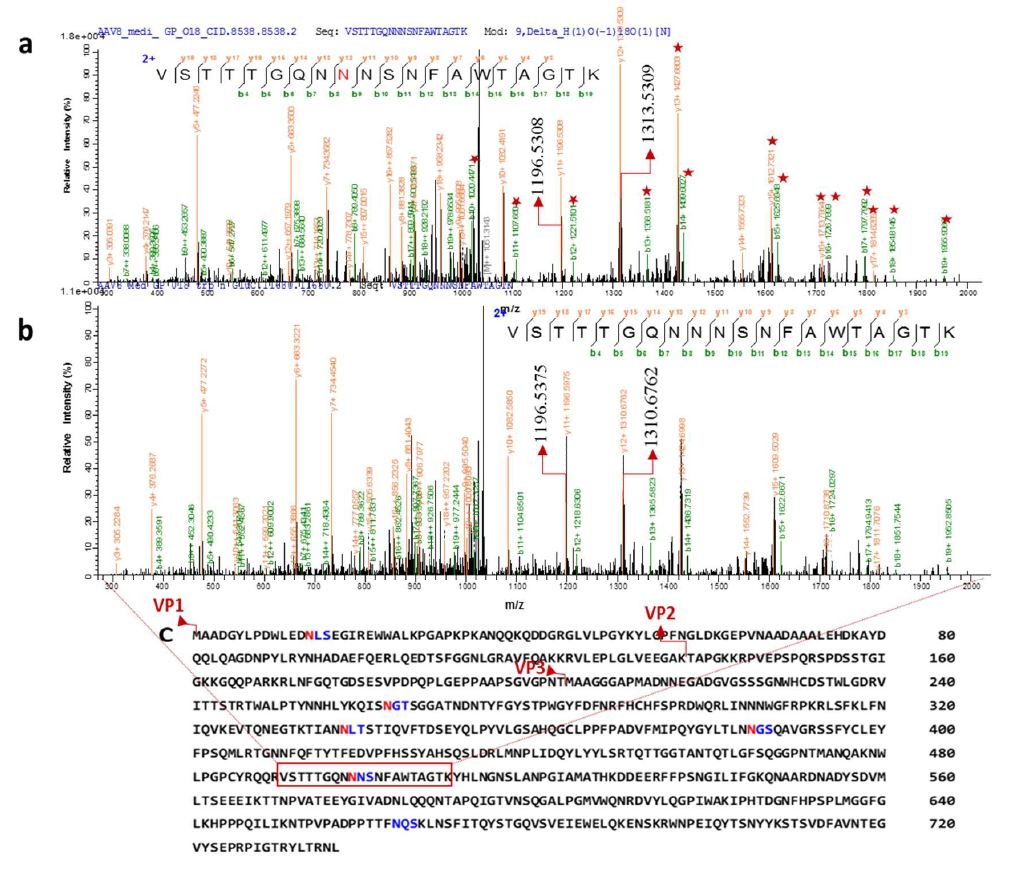
Figure 4. Two distinct tandem mass spectra of peptide sequence “VSTTTGQNNNSNFAWTAGTK” of the AAV8 capsid protein (in the common region of VPs). Characterized CID spectra of glycosylated peptide after 18 O mediated digestion. ( a ) The position of de-N-glycosylated asparagine 499 ( 18 O-incorporated aspartic acid) was attested by mass increment of 2.8547 Da (theoretical mass difference 2.98 Da) to the series of b and y ion (the precursor ion mass: m/z 2101.93193). ( b ) The position of Non-glycosylated asparagine 499 in the sequence was confirmed by y12/b8 ions (the precursor ion mass: m / z 2099.0766 Da). The highlighted ions (marked with a star) shows the mass differences from the non-glycosylated peptide mass spectrum. y11+ (highlighted) ions are same in both the spectra. ( c ) Capsid protein amino